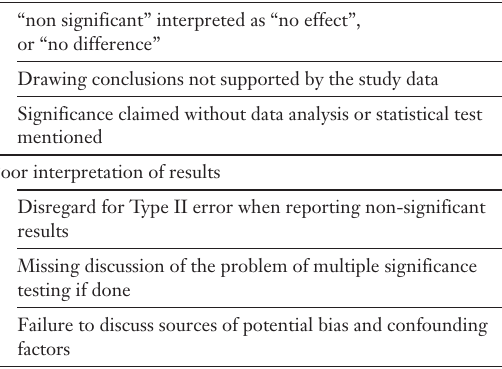
Statistical errors and deficiencies related to the interpretation of study